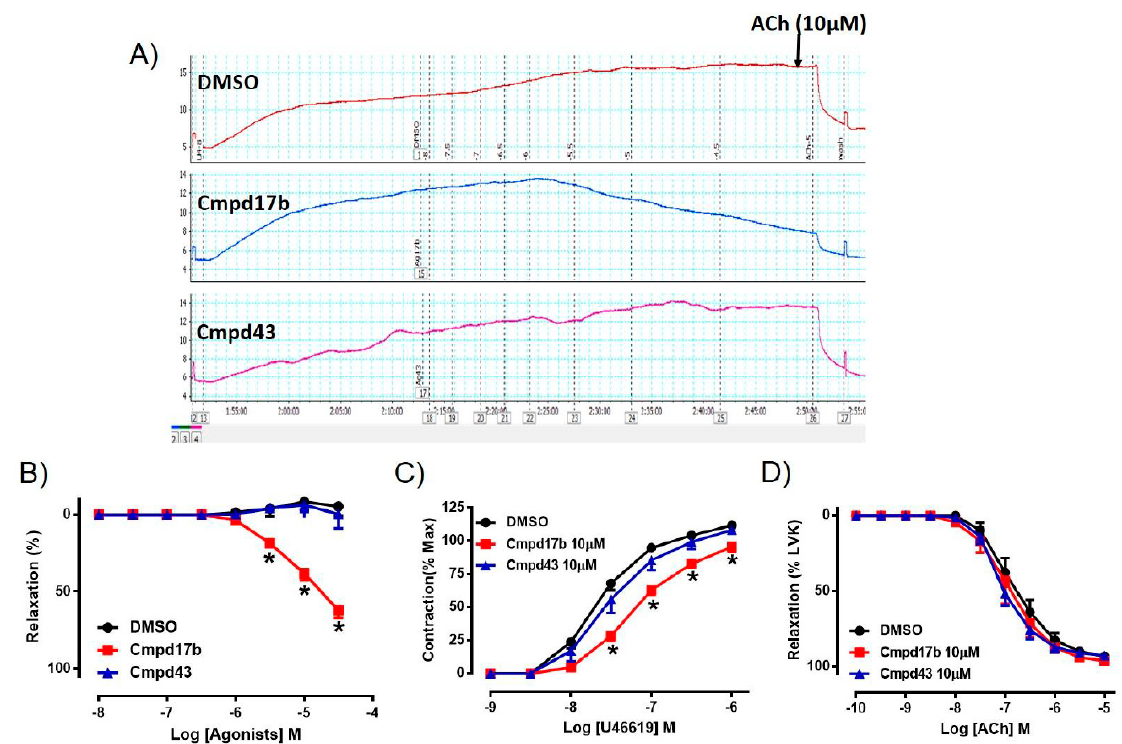
Figure 2. A representative tracing of ( A ) vascular reactivity in the abdominal aorta of male mice during a dose response curve to control (DMSO), Cmpd17b, and Cmpd43, prior to exposure to ACh. Concentration–response curves to ( B ) control, Cmpd17b, and Cmpd43 in the aorta of male mice. Concentration–response curves to ( C ) U46619 and ( D ) ACh from male aorta incubated with DMSO (control), Cmpd17b, or Cmpd43. Values are expressed as mean ± SEM, n = 5 per group. Sensitivity (pEC 50 ), maximum relaxation (R max ), and maximum constriction (E max ) values are shown in Supplementary Table S3. * P < 0.05, significantly different to vehicle control.